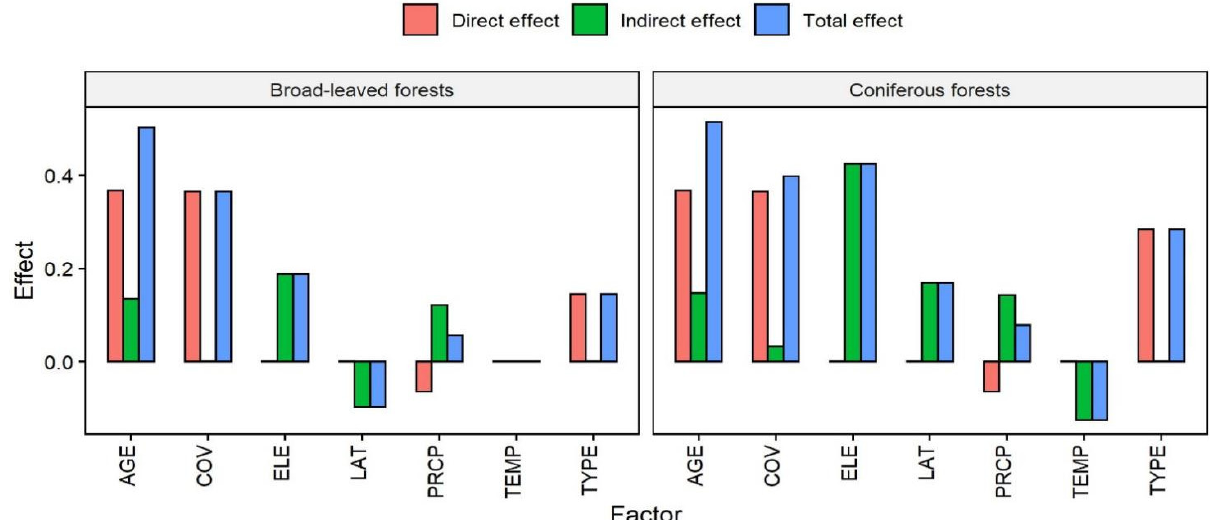
Figure 6. Direct, indirect and total effects of stand age (AGE), stand coverage (COV), forest type (TYPE), elevation (ELE), latitude (LAT), mean annual temperature (TEMP) and precipitation (PRCP) on biomass carbon density for natural broad-leaved and coniferous forests. The detailed process of calculating direct and indirect effects of all factors on biomass carbon density shows in Tables S1 and S2 of Supplementary Materials.